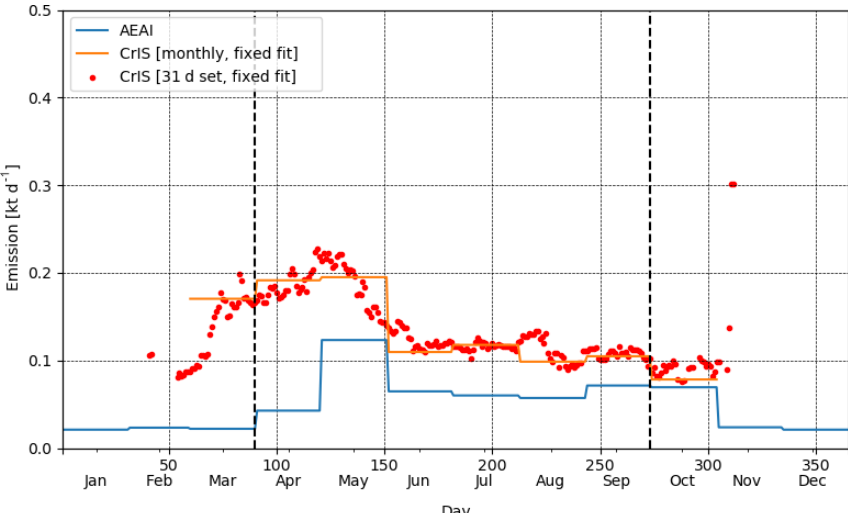
Figure 17. Time series of monthly NH 3 emissions over Lethbridge (Alberta, Canada). The monthly emissions following the Canadian AEAI 2013 inventory are shown in blue, which are summed over the Lethbridge region (a box with a bottom-left corner of (49.35 ◦ , − 113.31 ◦ ) and a top-right corner of (50.28 ◦ , − 111.10 ◦ )). The orange line shows the CrIS monthly estimated emissions using a lifetime of 2.65h and a plume spread of 19km, both of which are derived from the 5-year data record. The red dots are the corresponding CrIS-derived emissions in daily increments that are derived using a 31d interval (with 5 years, namely 2013–2017). The vertical dashed black lines indicate the beginning and end of the warm season over this